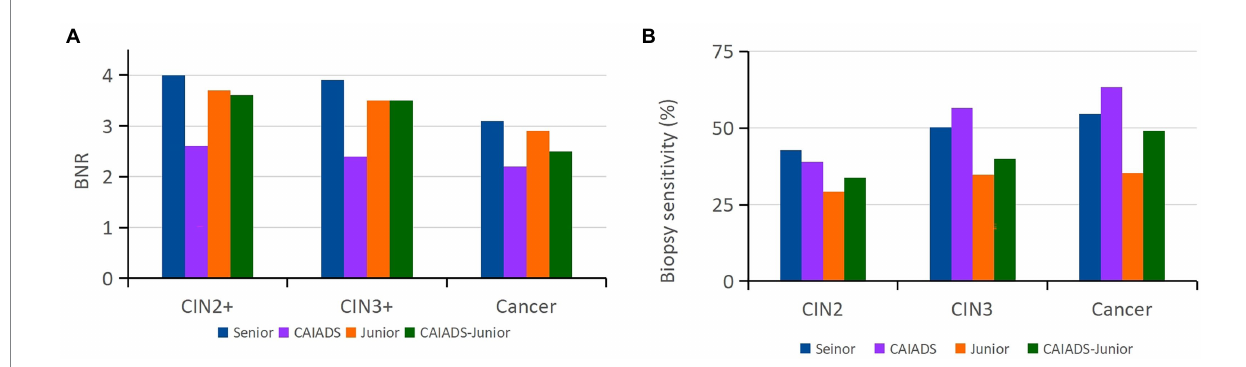
FIGURE 3 Biopsy efficacy and sensitivity of the subspecialists. (A) Number of biopsy sites required to detect each high-grade cervical lesion by the subspecialists. (B) Biopsy sensitivity of the subspecialists for each cervical lesion. CAIADS, colposcopic artificial intelligence auxiliary diagnostic system; CAIADS- Junior, CAIADS-assisted junior colposcopist; BNR, number of biopsies needed to detect each case for different endpoints (CIN2+/CIN3+/cancer); CIN, cervical intraepithelial neoplasia; CIN2+, CIN2 or worse; CIN3+, CIN3 or